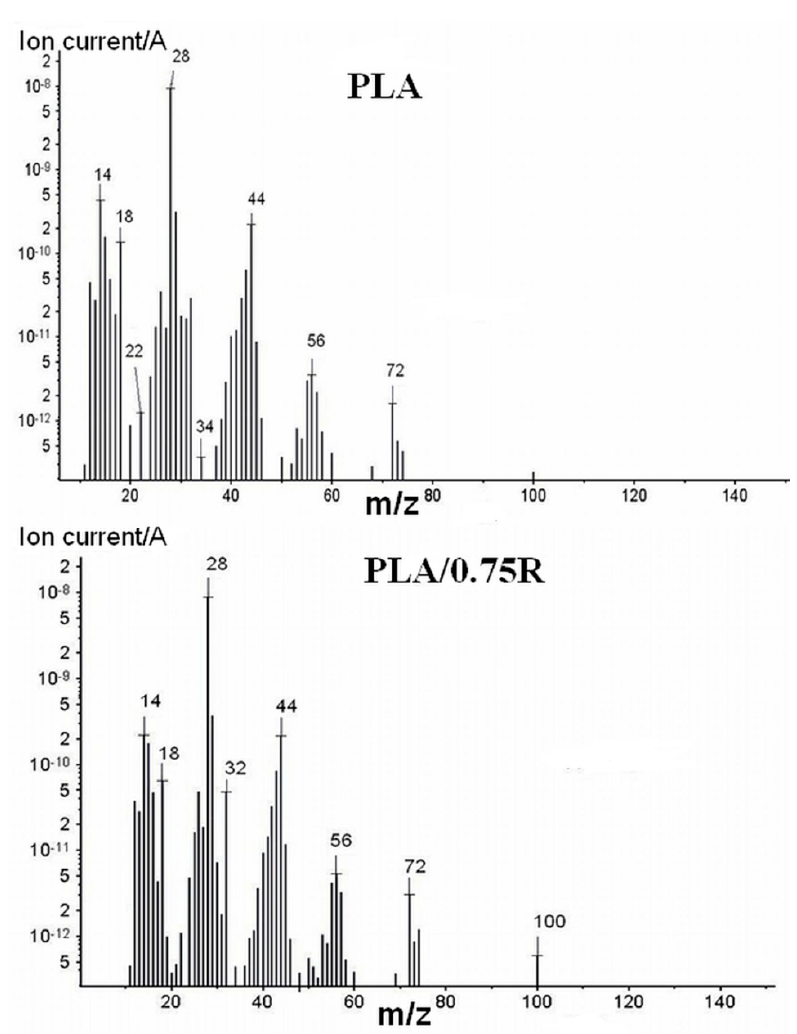
Figure 12. MS spectra of the thermal degradation products resulted from PLA and PLA/0.75R.